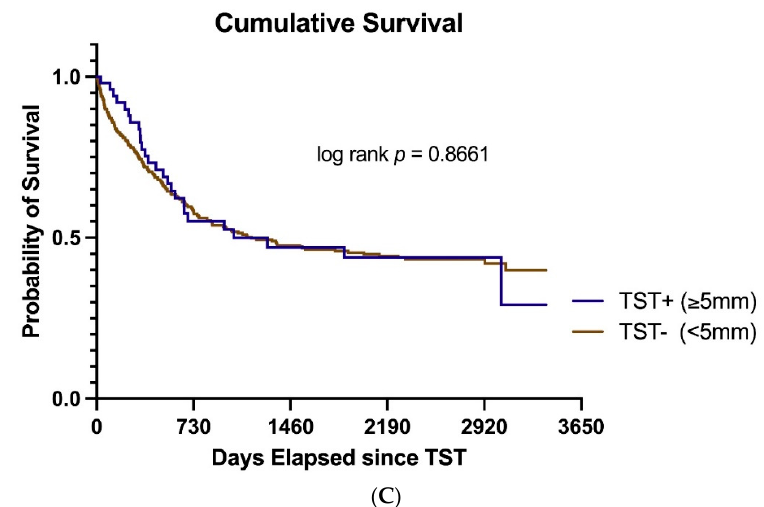
Figure 2. Cumulative survival. ( A ) Overall survival in 37 patients with acute leukemia who received LTBI therapy compared to 352 patients who were not treated. ( B ) Overall survival in the 37 patients who were TST positive ( ≥ 10 mm of induration, n = 37) compared to those who were TST negative ( n = 352). ( C ) Overall survival in patients with TST of ≥ 5 mm of induration ( n = 51) compared to those with negative TST (<5 mm of induration, n =